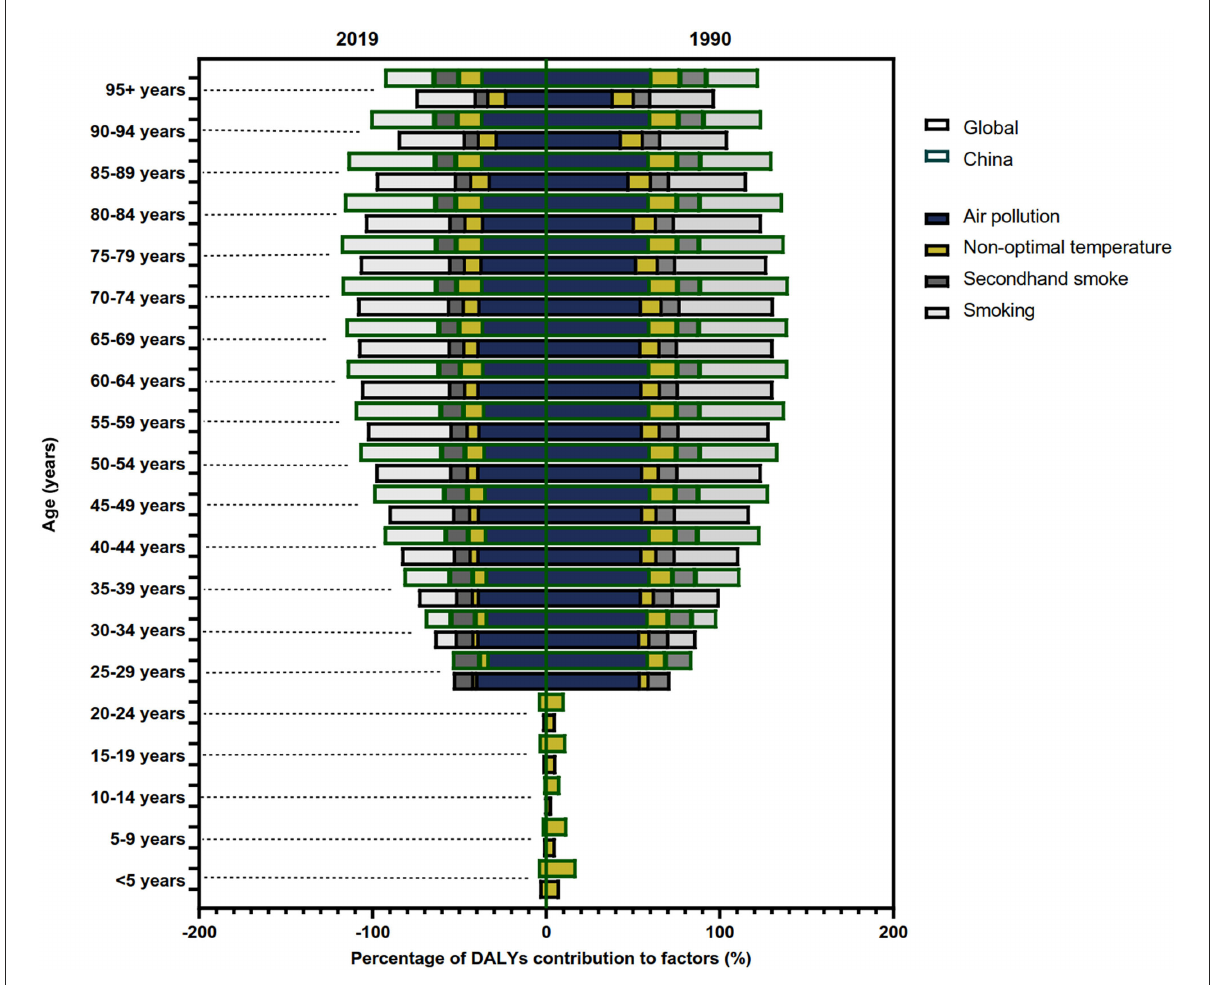
FIGURE7 The contribution of risk factors to DALY of COPD in China and the world in different